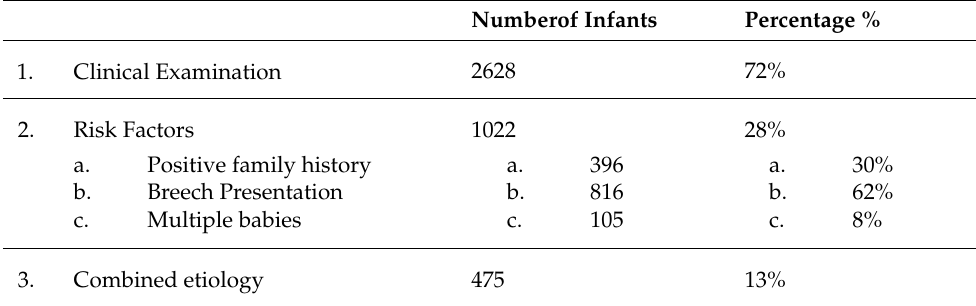
Table 1. Reasons for referral to the orthopaedic unit.